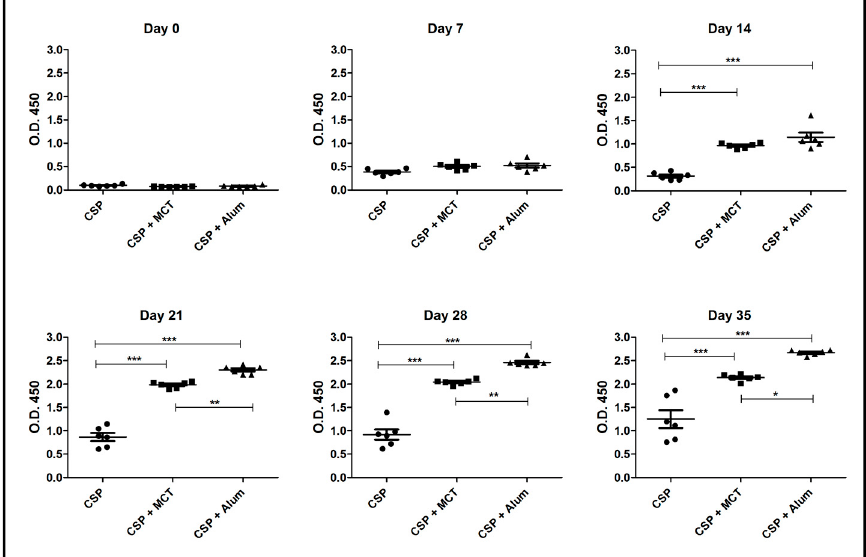
Figure 4. ELISA results of total IgG against CSP 210-247. Groups of mice were immunized as shown in Figure 3. Group 1 was vaccinated with only CSP without adjuvant, group 2 received CSP + MCT adjuvant and group 3 CSP + Alum (aluminum hydroxide). Six BALB/c mice per group were vaccinated intramuscularly with 7.5 μ g of each vaccine and bleed weekly. The results were analyzed using GraphPad Prism software applied to assess the means of groups by Tukey’s Multiple Comparison Test of one-way ANOVA. *** p value < 0.0001; ** p value < 0.001; * p value < 0.01.